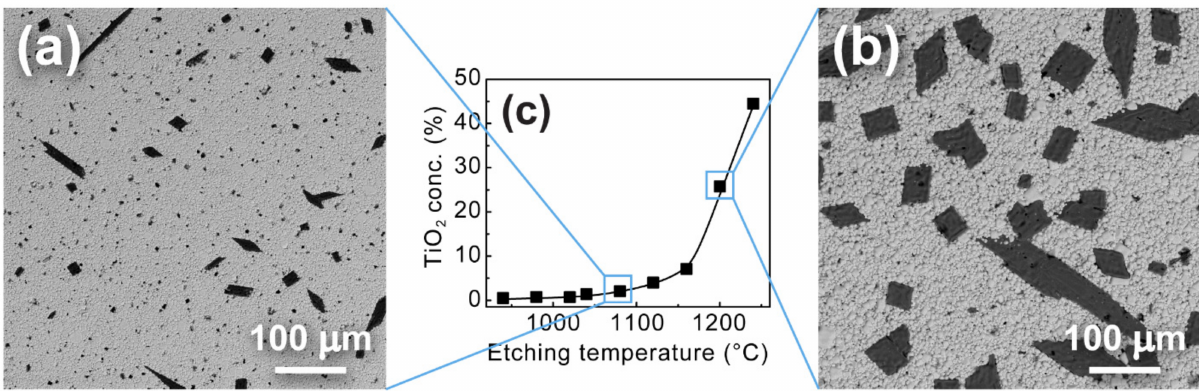
Figure 3. NBT-Eu grains with terrace patterns on rounded edges, observed at thermal treatment temperature of 1240 ◦ C ( a ) and NBT-Eu grains with sharp edges, observed at thermal treatment temperature of 1280 ◦ C ( b ).